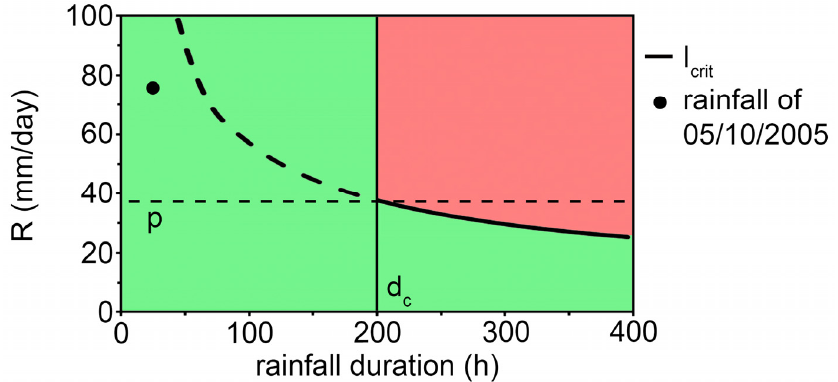
Figure 9. Comparison between the rainfall event recorded on 5 October 2005 and the critical curve calculated at the depth of 0.80 m.